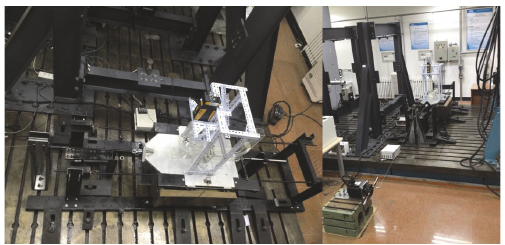
Figure 4: Photographs of experimental testing